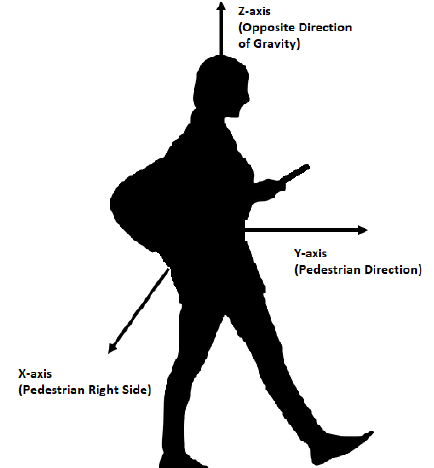
Figure 8. The illustration of the pedestrian coordinate system The extracted eigenvectors from the global accelerations of device coordinate system are shown in Figure 9.The vector right has the problem of 180 ambiguity for each step (Kunze, Lukowicz et al., 2009), R may be the right or left of the body. To solve this ambiguity, the orientations of the acceleration values are analyzed as the smartphone Swinging in different hands. According to the results of the analysis, the right R-value is proportional to the user coordinate system. For example, when the user carries the smartphone in Swinging mode on the right hand side of his body, the Z axis of the device coordinate system is almost to the left of the body, so the (cid:148) (cid:2936) components of the R vector must be negative for each step.